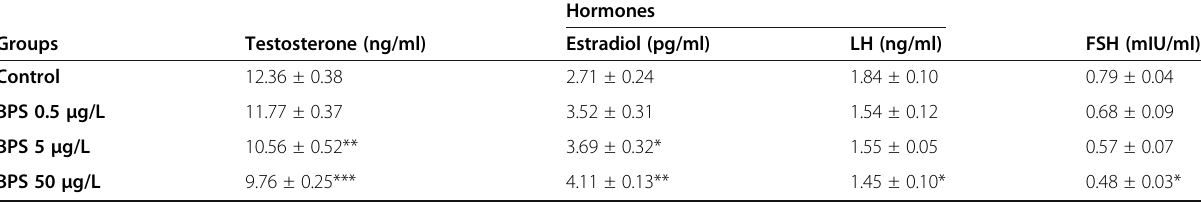
Table 3 Effect of chronic exposure of different concentrations of BPS (0.5 μ g/L, 5 μ g/L, and 50 μ g/L) on plasma testosterone and estradiol concentrations in male